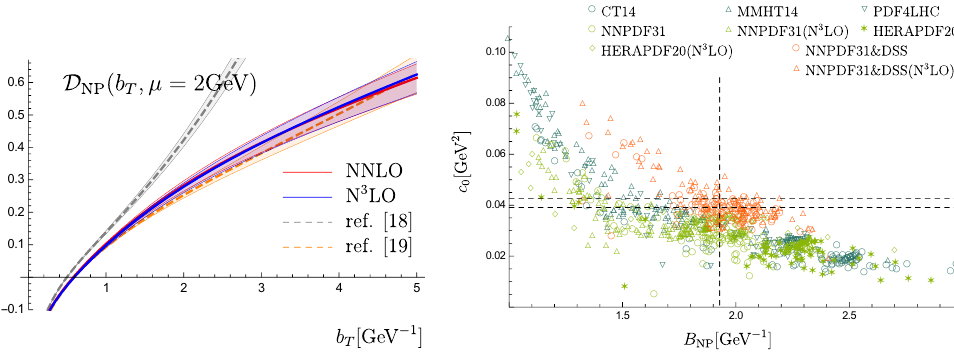
Figure 23 . (Left) Comparison of NNLO RAD extracted in DY (cid:12)t (NNPDF31), and global (cid:12)t of DY and SIDIS (NNPDF31& DSS). Shaded area shows the 1 (cid:27) -uncertainty band. The dashed lines show the extraction made in refs. [18] and [19] at LO and NNLO of RAD correspondingly. (right) Distribution of replica points in di(cid:11)erent (cid:12)ts of RAD. Dashed lines show the mean values of RAD extracted in the global (cid:12)t of DY and SIDIS.